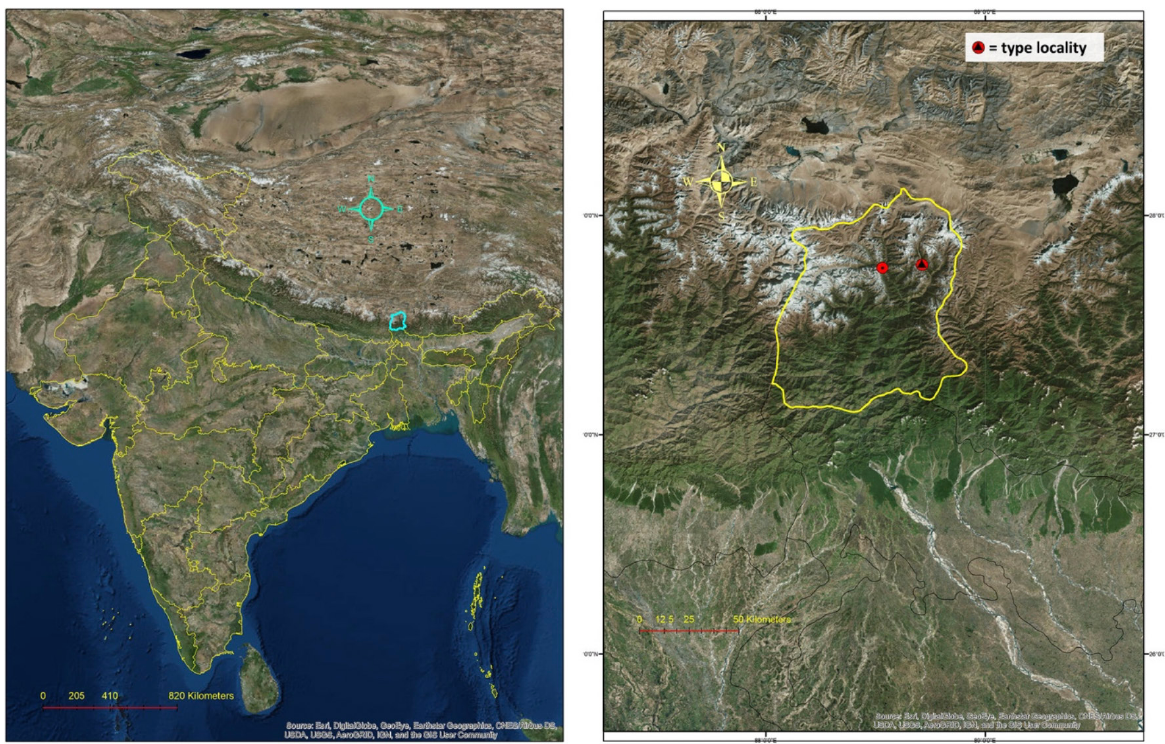
Image 4. Distribution map of Epilobium